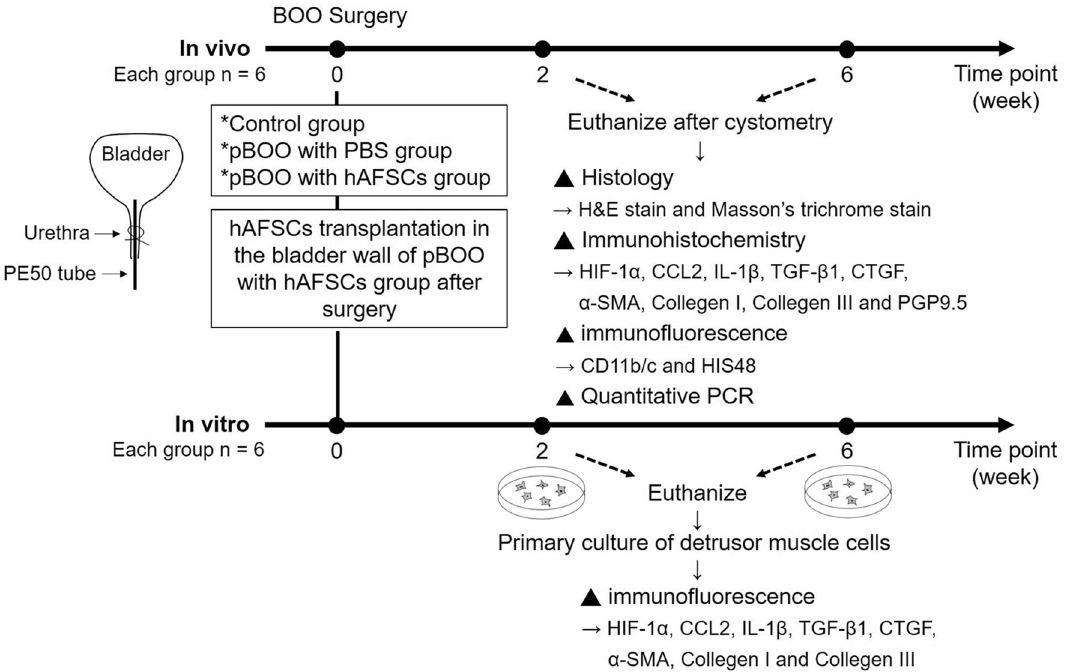
Figure 1. Schema of the experimental procedure. pBOO = Partial bladder outlet obstruction, PBS = Phosphate- buffered saline, hAFSCs = Human amniotic fluid stem cells, H&E = Hematoxylin and eosin, PCR = Polymerase chain reaction, HIF1α = Hypoxia inducible factor-1α, IL-1β = Interleukin-1β, TGF-β1 = Transforming growth factor-β1, CTGF = Connective tissue growth factor, α-SMA = α-smooth muscle actin, PGP9.5 = Protein gene product 9.5. Drawn by co-author, Yung-Hsin